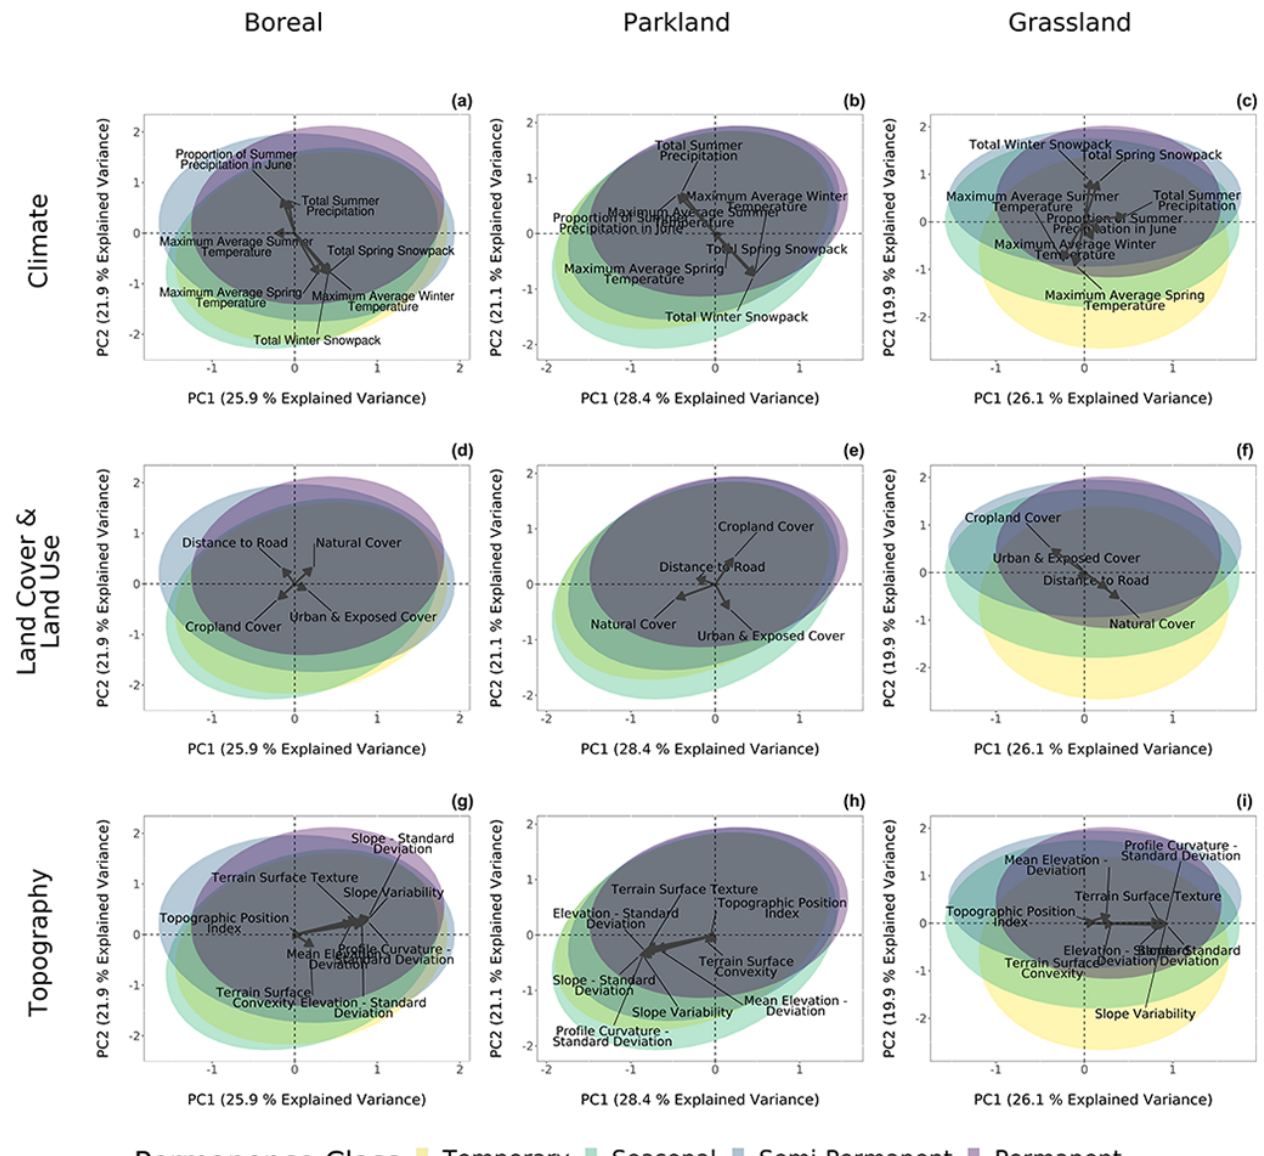
Figure 2. Principal components analysis for wetlands delineated in the (1) Boreal Forest (totalling 12000 wetlands), (2) Parkland (totalling 12000 wetlands) and (3) Grassland (totalling 16000 wetlands) natural regions. PCAs apply an orthogonal transformation to summarize the data into axes that explain the variance between two correlation matrices. Our data were scaled before implementing the PCA. Vectors on climate (a–c) , land use and land cover (d–f) , and terrain roughness (g–i) show correlations with both axes. Axis 2, for all datasets, represents a hydroperiod gradient, and terrain roughness is represented on axis